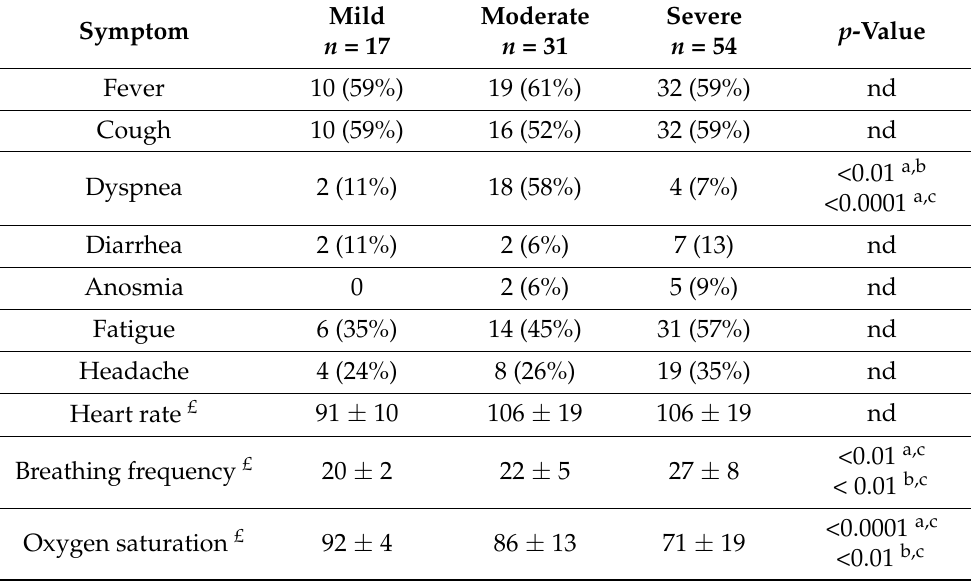
Table 2. Symptoms and signs presented in COVID-19